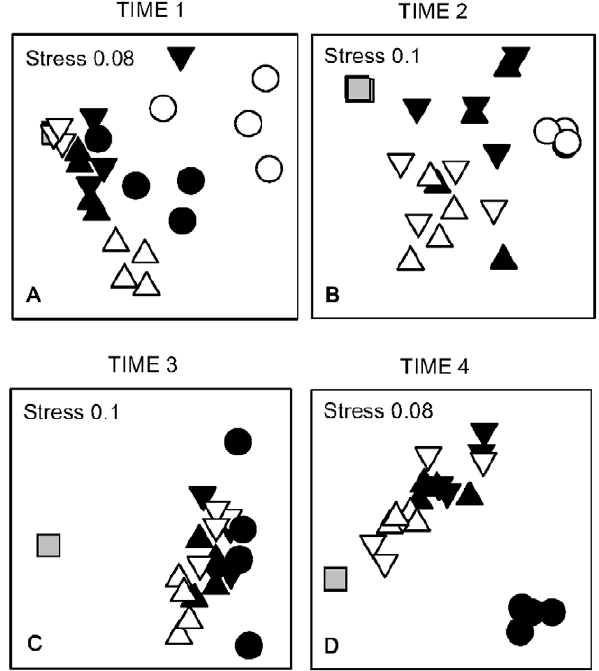
Figure 5. nMDS of assemblages on panels submerged for 3 months at the effluent site (squares), 600 m away from the effluent (triangles), 1400 m away from the effluent (inverted triangles) and controls (circles) in Time 1 (A), Time 2 (B), Time 3 (C) and Time 4 (D). Full symbols are to show sites on the same side of the bay (i.e. N or S) and to differentiate both controls (filled circles are control 1 - the intake, and empty circles are control 2). n =4; Note that in times 3 and 4, only one control site (C2) was sampled due to losses of replicates.